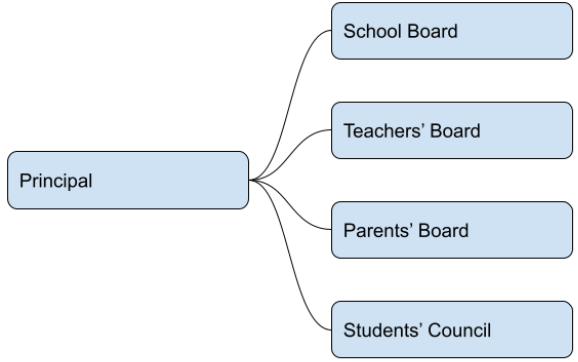
Figure 1. Organizational scheme of vocational schools.